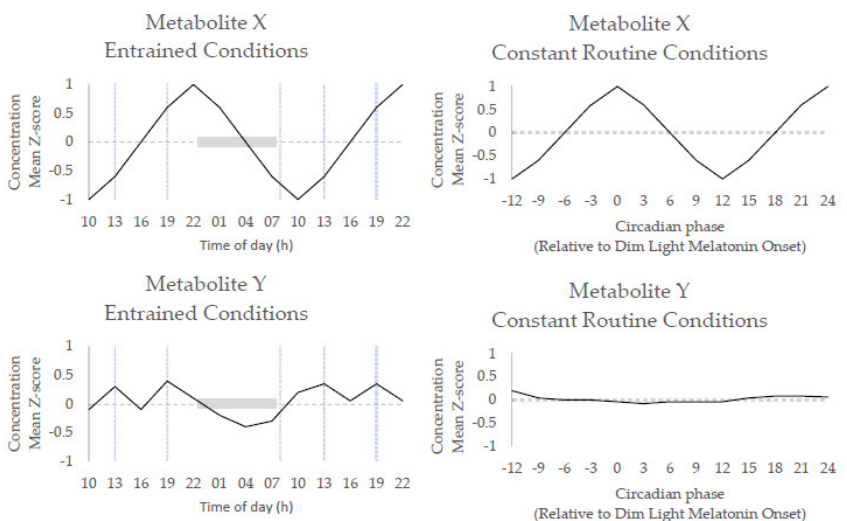
Figure 1. Mock data representation of two biological rhythms (e.g., metabolite rhythms) X (top) and Y (bottom) under entrained conditions (left) and constant routine (right). Entrained conditions consist of a light/dark cycle, meals at 08:00, 13:00, 19:00 h (shown by dashed vertical lines) and designated sleep time between 23:00 and 07:00 h (shown by grey shading of x-axis). ( Top-left ): Metabolite X: A rhythm with a regular 24 h period under entrained conditions may or may not be influenced by Zeitgeber (e.g., wake/sleep). ( Top-right ): Metabolite X: The rhythm observed under entrained conditions persists and maintains its 24 h periodicity under constant routine, the amplitude may or may not change between the conditions, and the rhythm is considered circadian. ( Bottom-left ): A rhythm with a more complex cycle, but regular 24 h period, and peaks correspond to mealtimes under entrained conditions (08:00, 13:00, 19:00 h), suggesting some effect of feeding/fasting cycles. ( Bottom-right ): The rhythm is significantly dampened in constant routine (does not persist), with a regular period/amplitude no longer detectable. The rhythm of metabolite Y is not considered circadian in nature, as it did not persist under constant routine conditions, and is classed as a diurnal rhythm, i.e., a rhythm evoked by exogenous cycles such as feeding/fasting and sleep/wake.